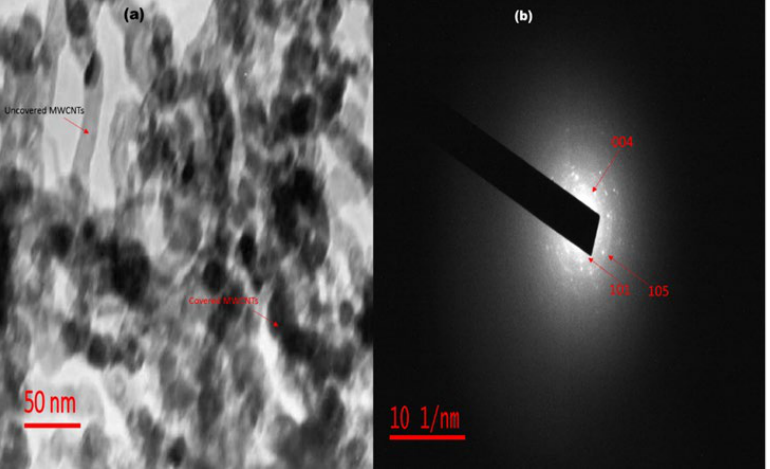
Figure 3. ( a ) TEM micrograph of FST3/C1; and ( b ) SAED diffraction ring patterns of FST3/C1.